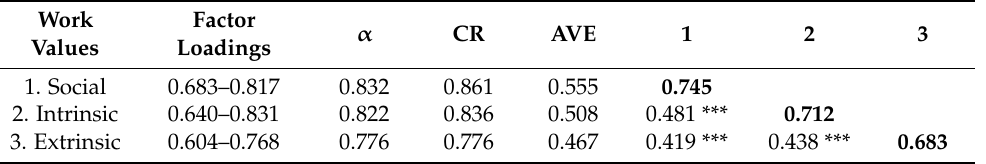
Table 4. Work values scale reliability and validity